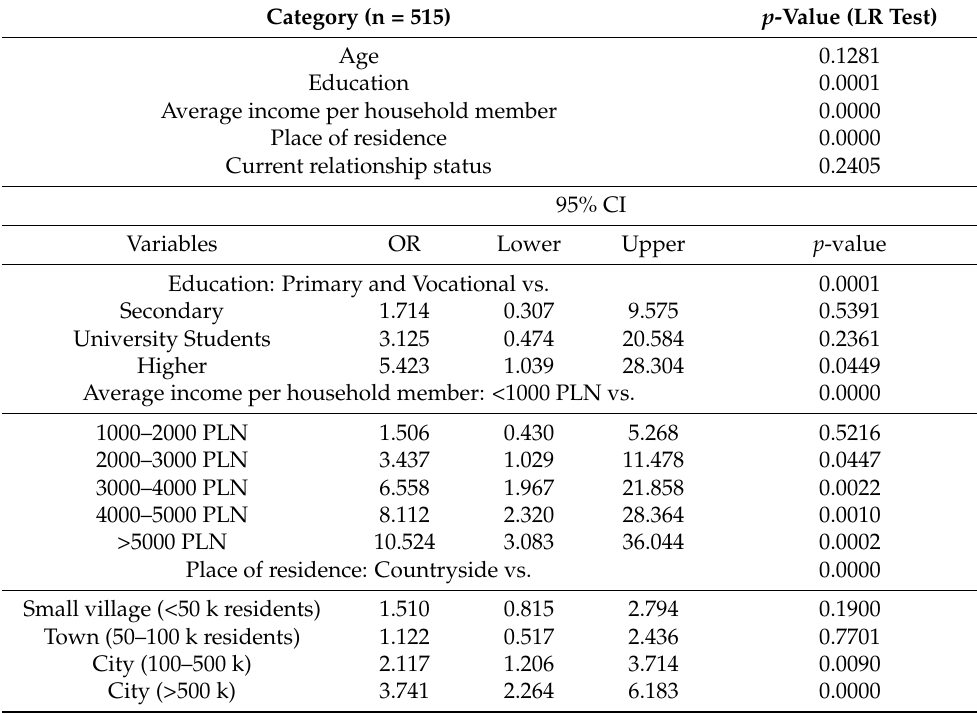
Table 9. Univariate regression analysis regarding COVID-19 vaccination